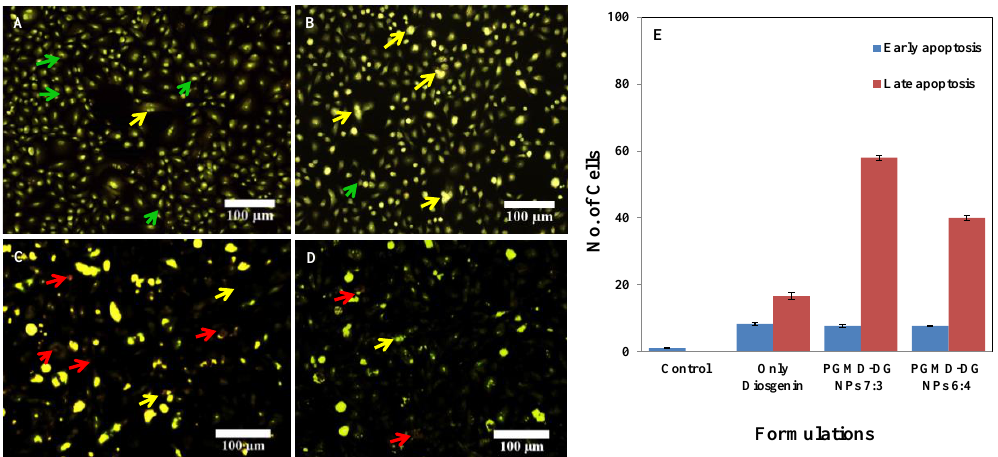
Figure 8. Acridine orange/Ethidium bromide staining in A549 cells. Untreated A549 cells ( A ) showed normal cellular structure (green arrows), early apoptosis (yellow arrows) including chromatin condensation, cell membrane blebbing was observed after treatment with Diosgenin only ( B ), and necrosis (red arrows) with ( C ) PGMD-DG NPs 7:3 and ( D ) PGMD-DG NPs 6:4. ( E ) Quantitative analysis of apoptosis with the treatment of diosgenin PGMD nanoparticles in A549 cells.